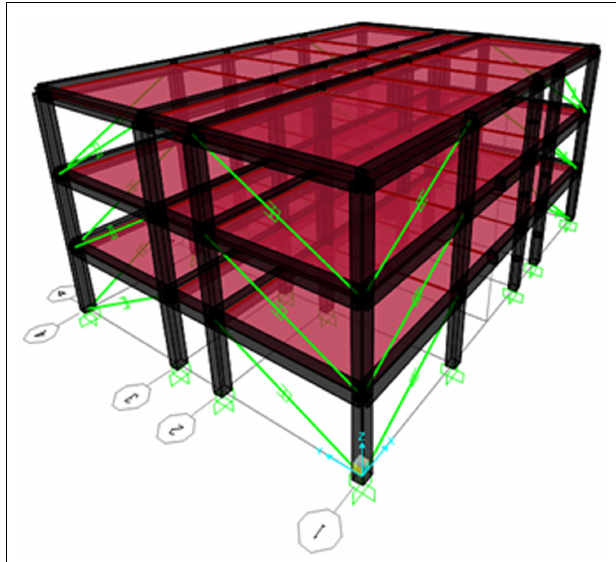
FIGURE 3 | SAP 2000 model of the structure equipped with inter-storey viscous dampers .